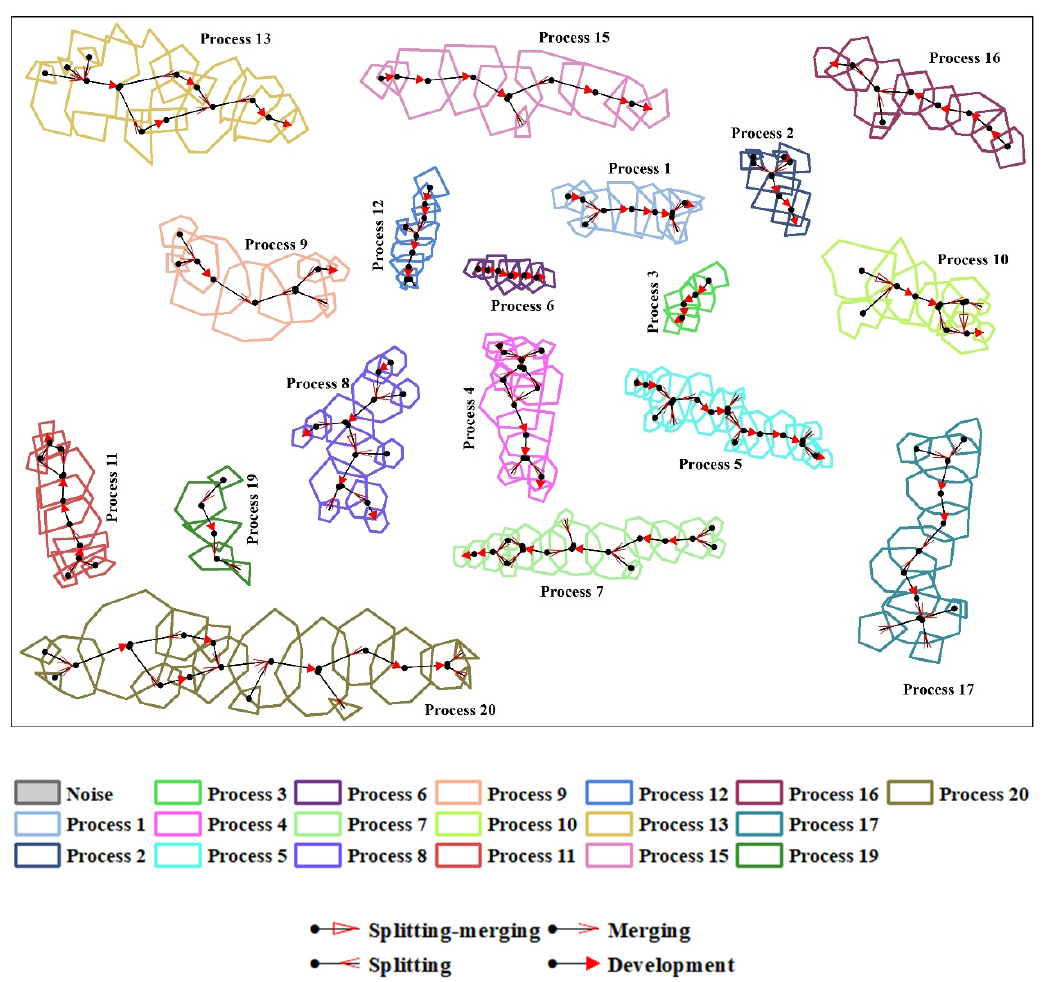
12 of 21 Figure 8. The optimal threshold of merging evolution for the simulated dataset. The triangle sym- bol is located at the inflection point of the curve, and the equation represents the value of the cor- responding variable at the inflection point. ( a , b ) are merging degree and relative importance of being merged objects, respectively.